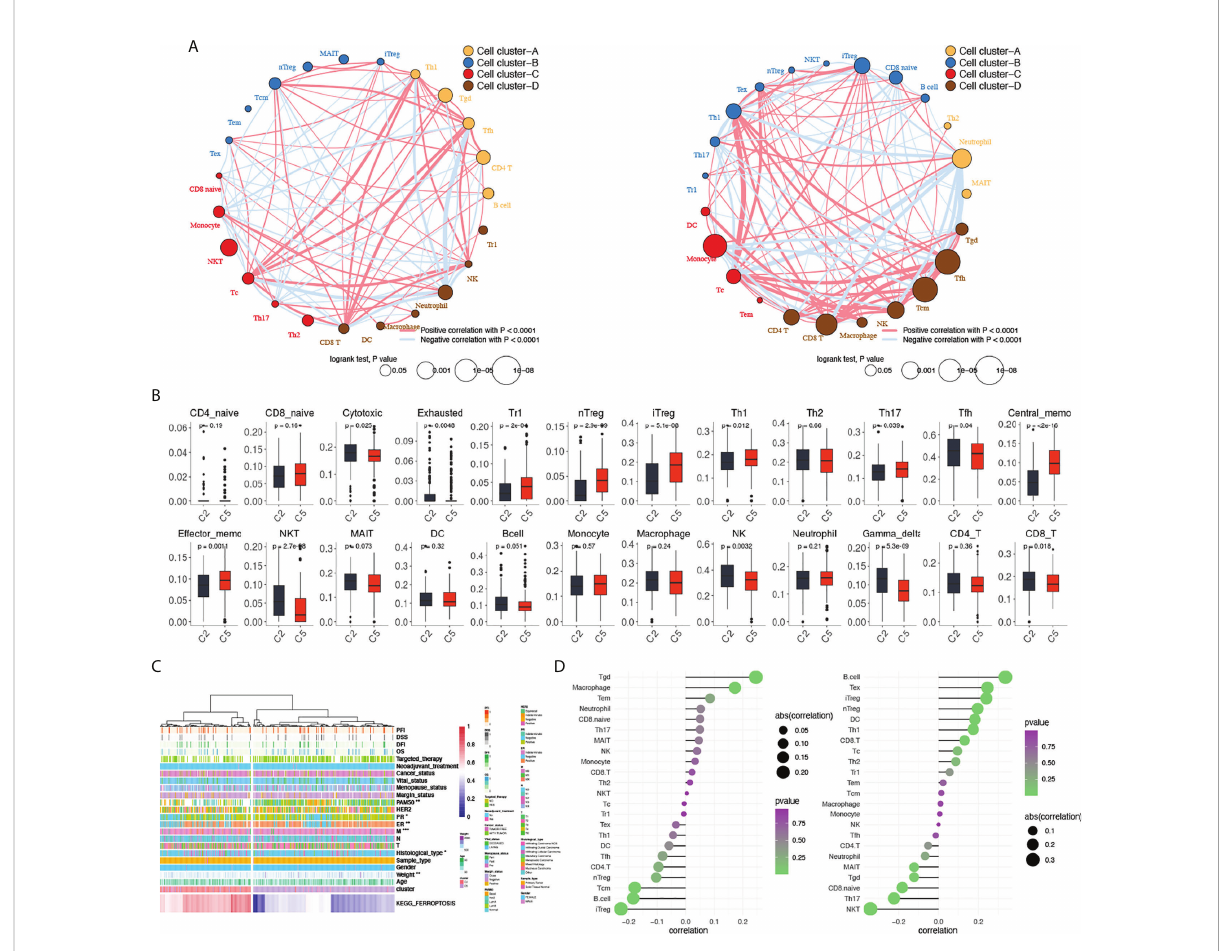
FIGURE 4 Comparisons of tumor-in fi ltrating immune cells between cluster 2 and cluster 5. (A) Clustering and correlations between tumor-in fi ltrating immune cells in cluster 2 (left) and cluster 5 (right). Red: positive correlation, blue: negative correlation. (B) Comparisons of tumor-in fi ltrating immune cells between cluster 2 and cluster 5. (C) . Heatmap of KEGG_FERROPTOSIS pathway alteration and clinical characteristics between clusters 2 and 5. (D) Correlations between KEGG_FERROPTOSIS and tumor-in fi ltrating immune cells between cluster 2 (left) and cluster 5 (right). A two-sided P -value < 0.05 was considered signi fi cant. *P < 0.05; **P < 0.01; ***P <